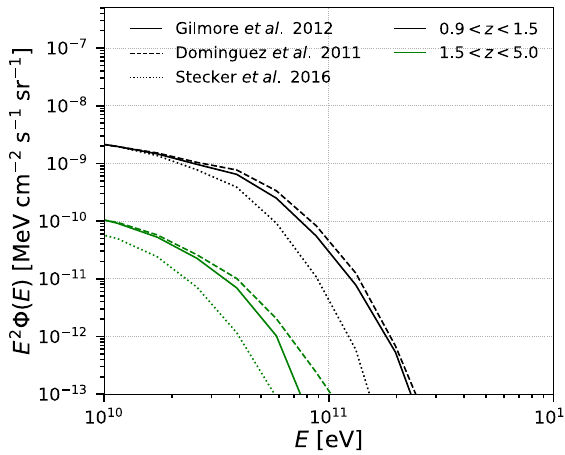
Fig. 3 | Effect of EBL attenuation on the gamma-ray fl ux for two redshift intervals and three different EBL models 20 – 22 . This fi gure indicates that the EBL fl ux attenuation is more prominent at high redshifts and sensitive to the adopted EBL model. The fl ux is plotted for α =2.3 and E max =10 17 eV.